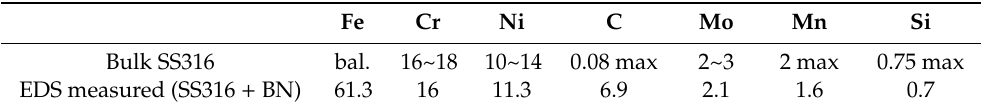
Table 1. A comparison of the chemical composition of SS316 between the bulk value and 3D printed part (electron dispersive x-ray spectroscopy (EDS) data analysis can be referred to Supplementary Information Figure S2). Fe Cr Ni C